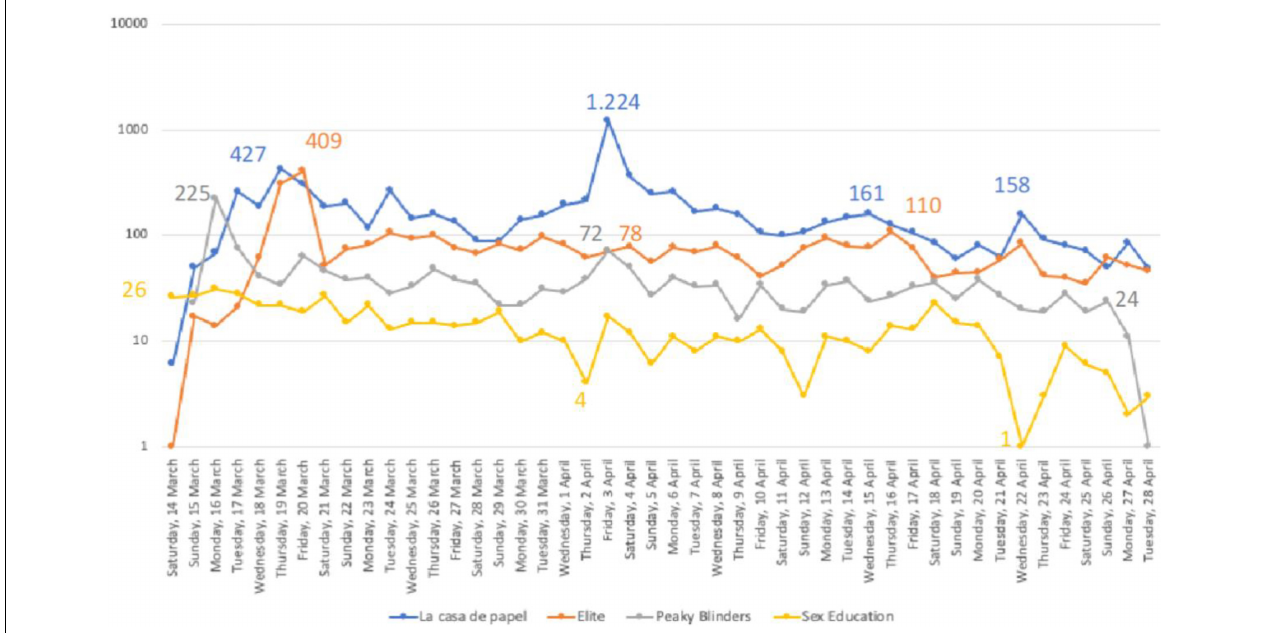
FIGURE 2 | Semi—logarithmic scale. Evolution of the references to coronavirus in the first lockdown phase.